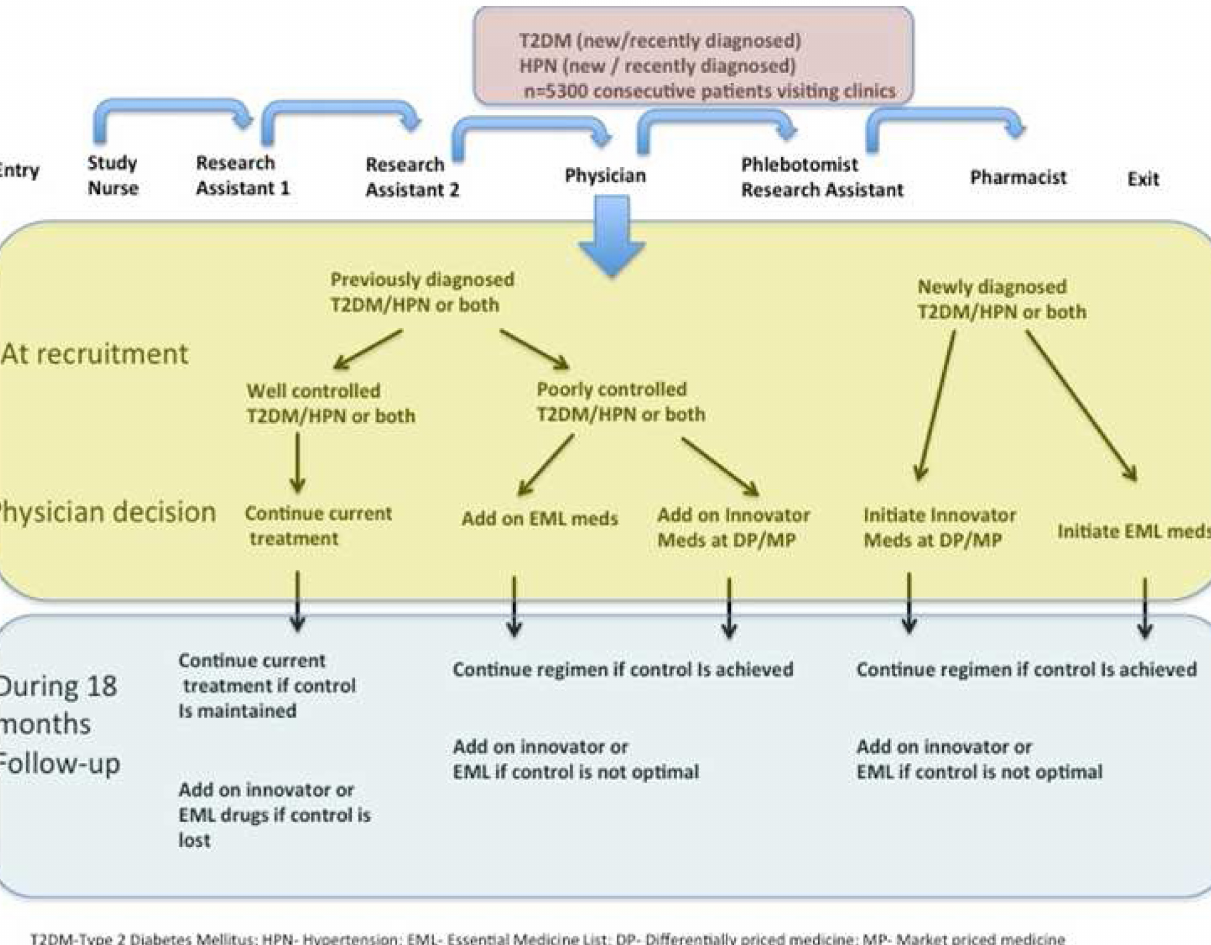
Figure 2. Flow of patients in clinic .